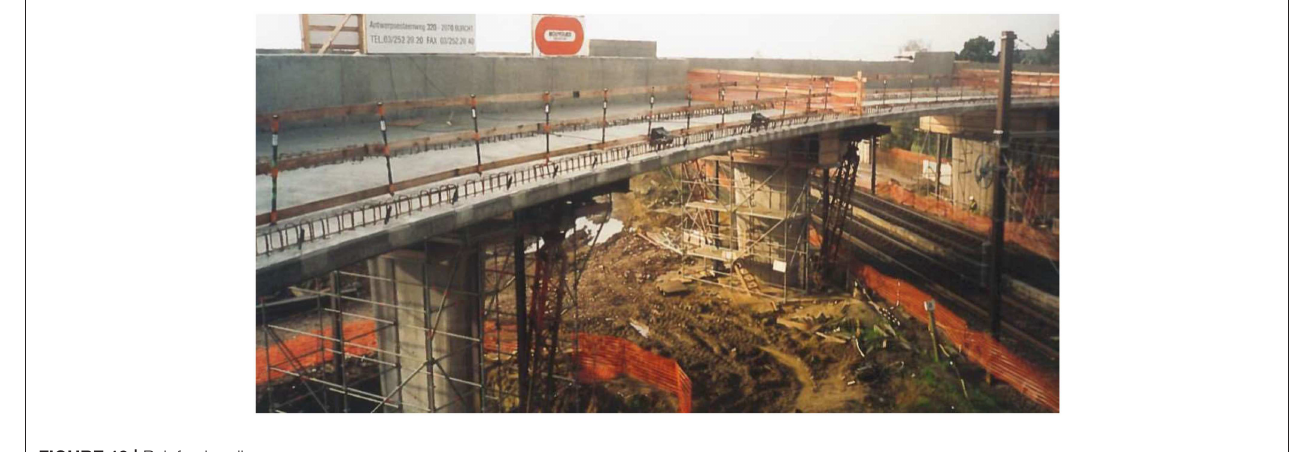
FIGURE 13 | Reinforcing rib.